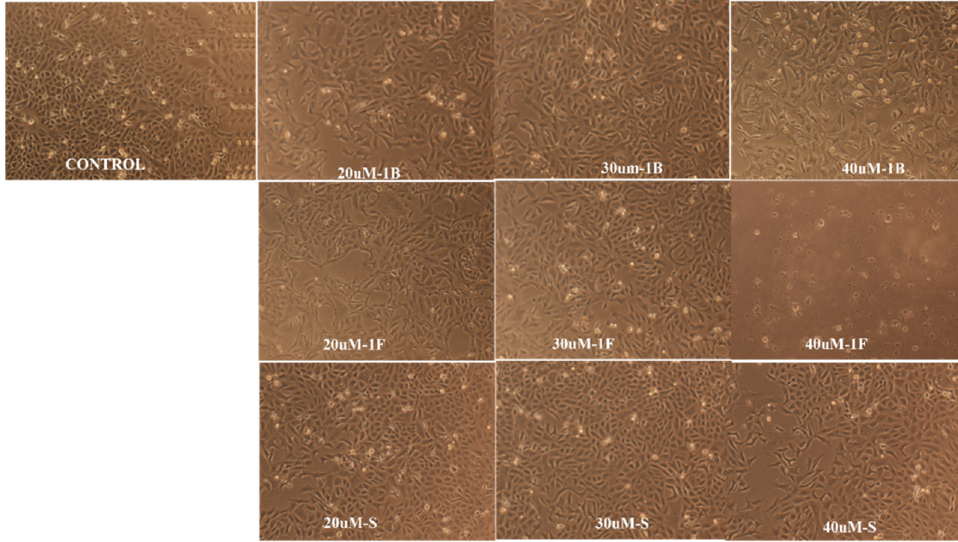
Figure 10. Morphological alterations of MCF7 cells after exposure to different formulations [opti- mized formulation (1F), suspension (S), blank (1B), and control] at different concentrations. Images were captured using a Nikon phase contrast microscope at ×10.